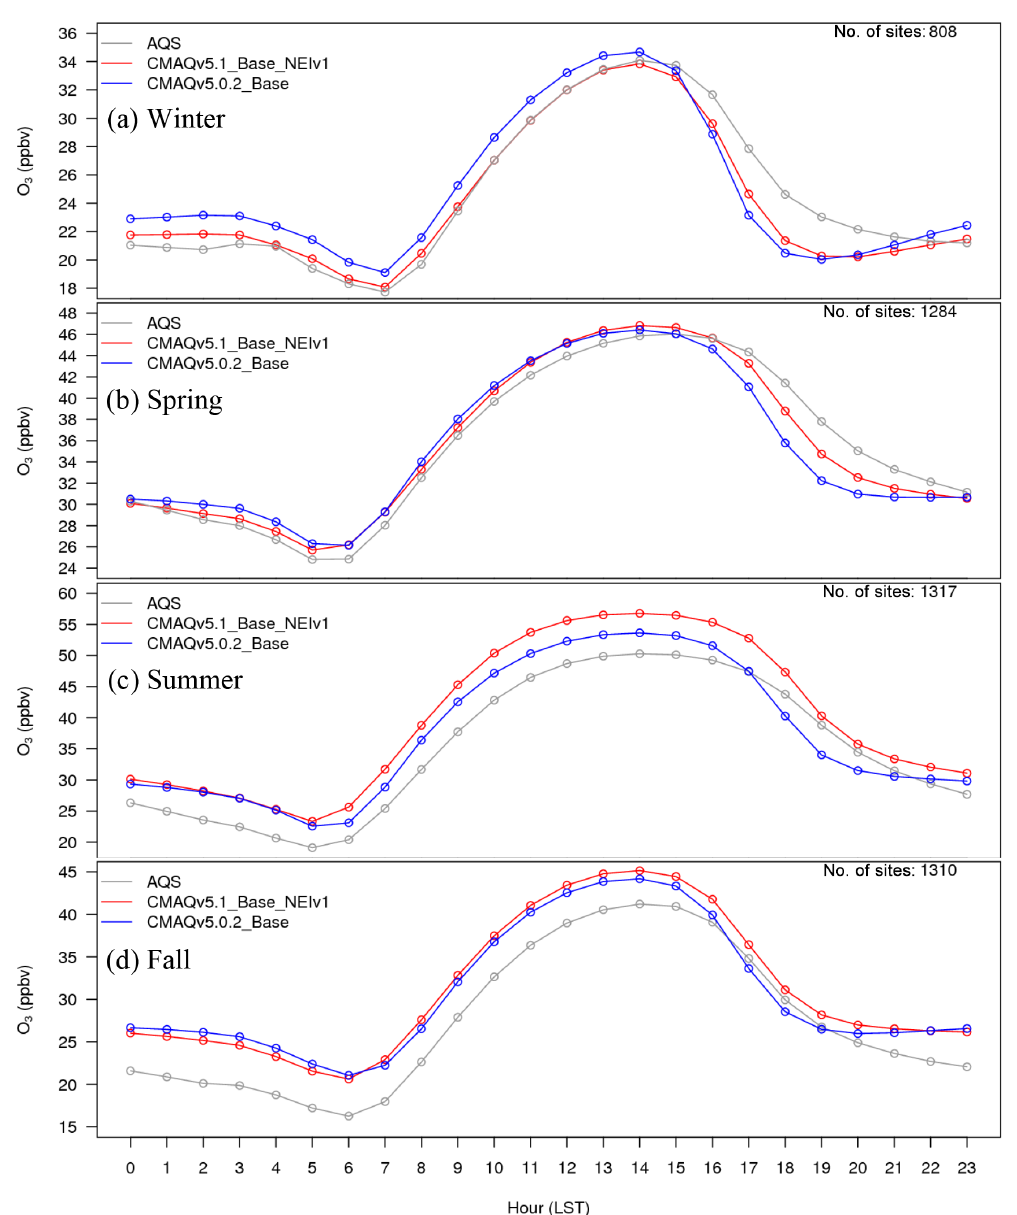
Figure 14. Diurnal time series of seasonal O 3 (ppbv) for AQS observations (gray), CMAQv5.0.2_Base simulation (blue) and CMAQv5.1_Base_NEIv1 simulation (red) for (a) winter, (b) spring, (c) summer and (d) fall.